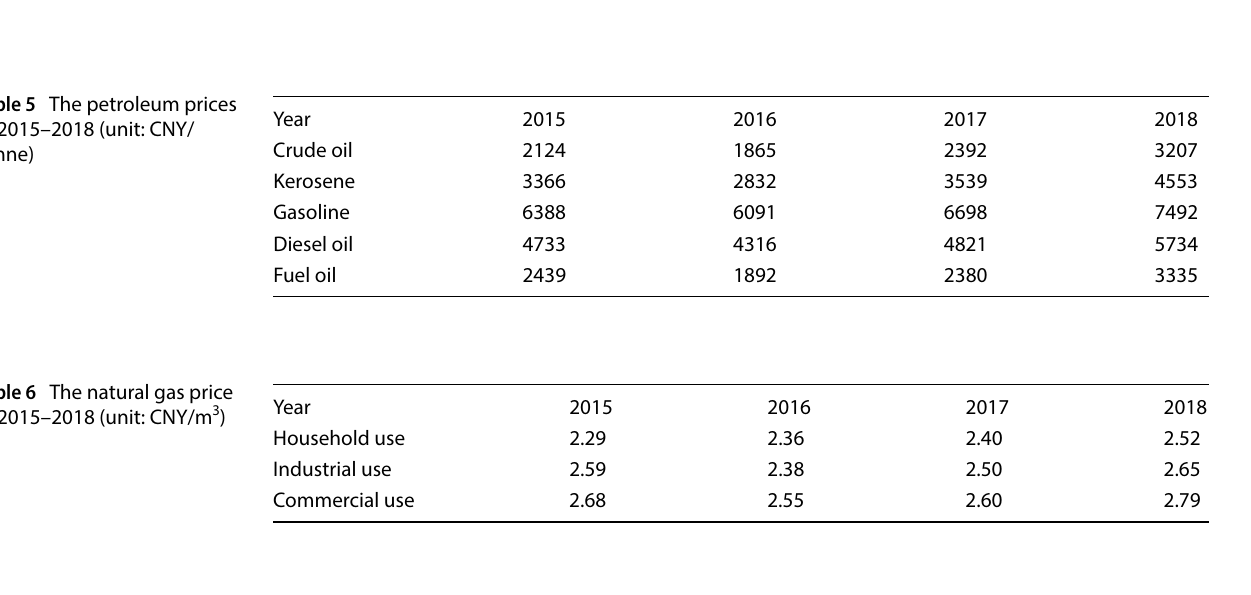
Table 7 The electricity price in 2015–2019 (unit: CNY/1000 kw h) Year Electricity